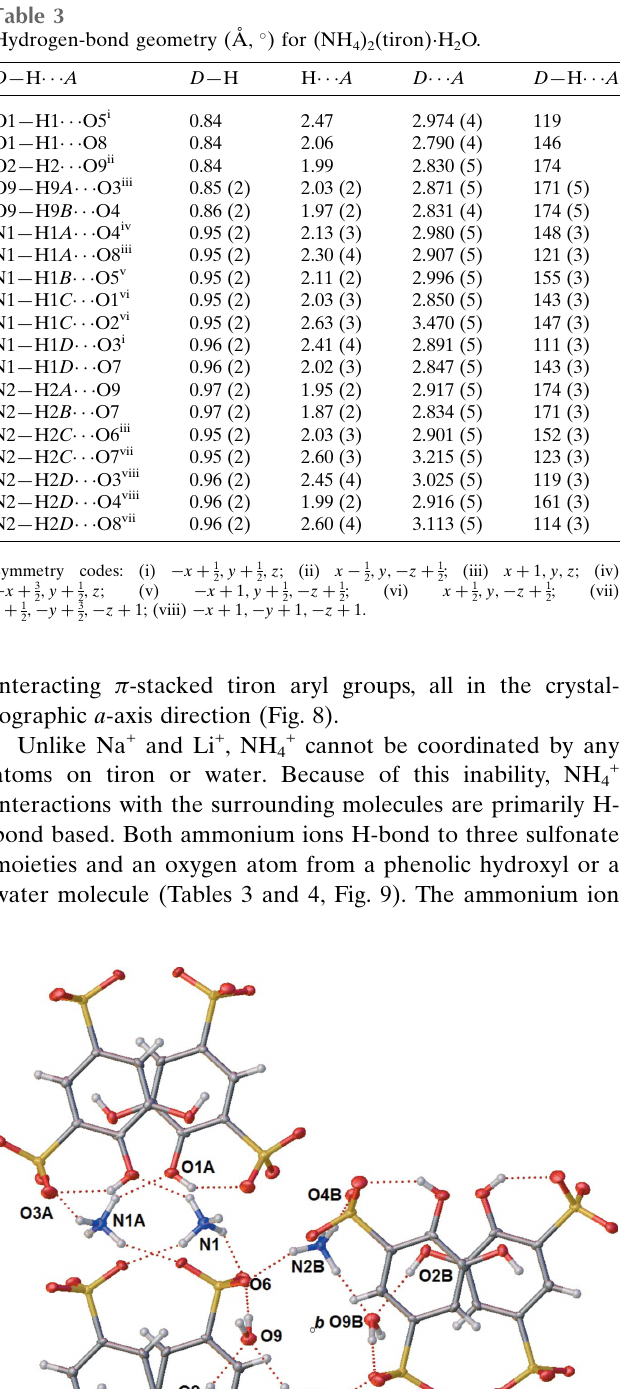
Table 4 H-bonding to all NH 4+ based protons in (NH 4 ) 2 (tiron) (cid:2) H 2 O.